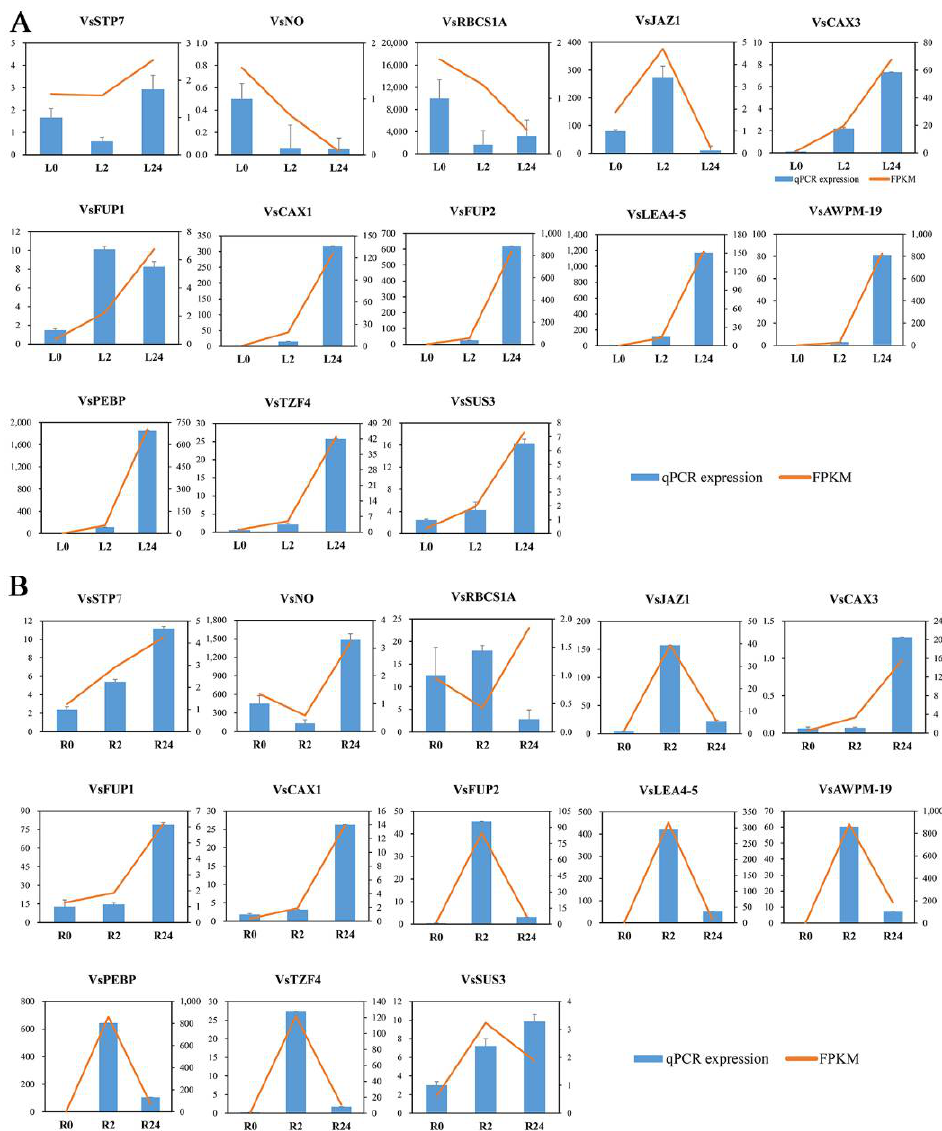
Figure 11. The expression patterns of thirteen selected genes identified by RNA-seq were verified by qRT-PCR. ( A ) Bar chart showing the expression changes in response to the L0 to L24 treatments for each candidate gene, as measured by RNA-seq and qRT-PCR. ( B ) Expression changes in re- sponse to the R0 to R24 treatments for each candidate gene, as measured by RNA-seq and qRT-PCR. STP7—sugar transporter protein 7; NO—NAD(P)-dependent oxidoreductase; RBCS1A—ribulose bisphosphate carboxylase small chain 1A; JAZ1—jasmonate-zim-domain protein 1;